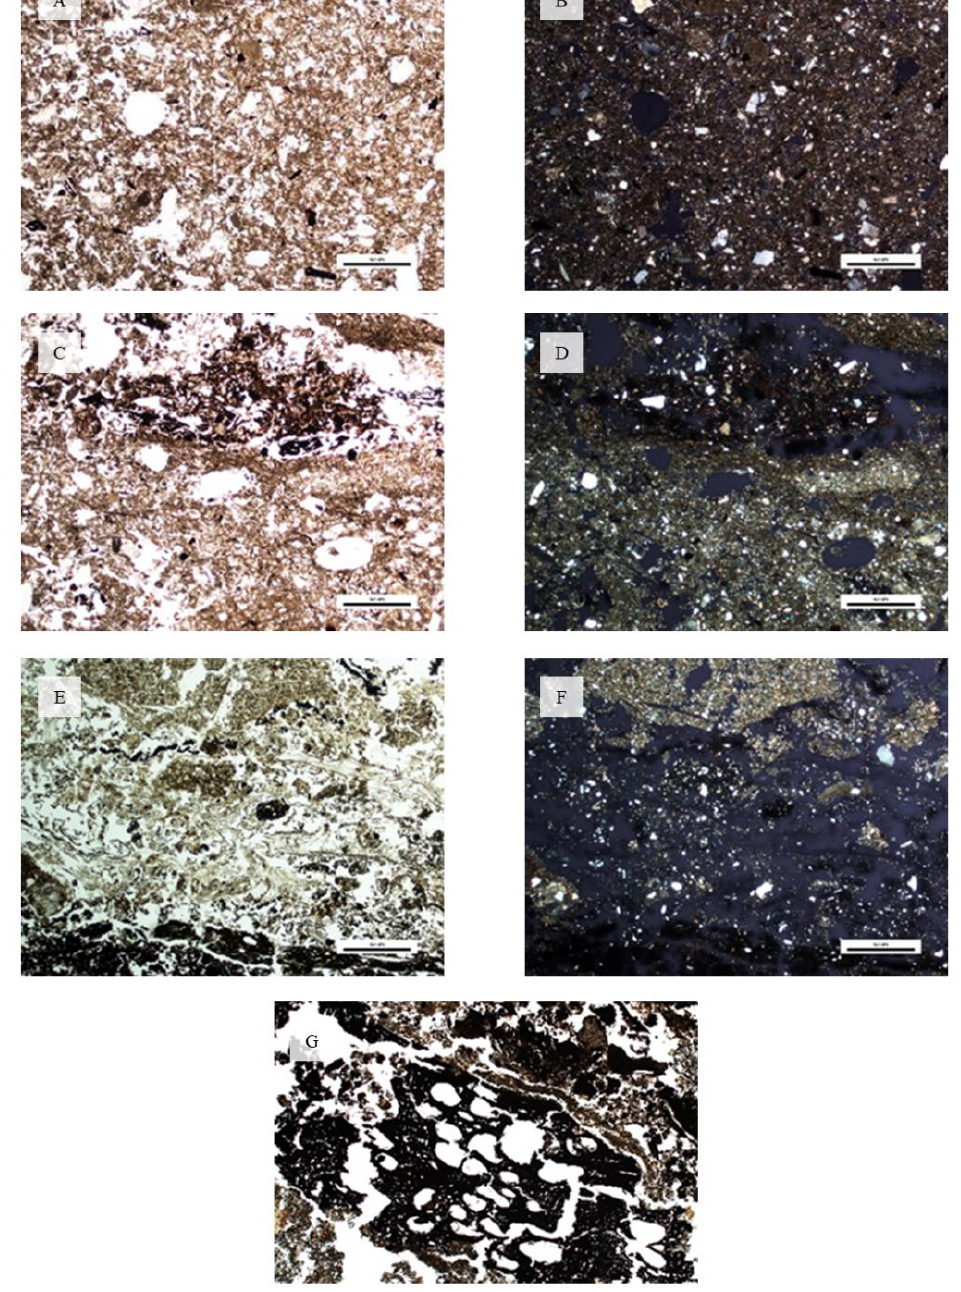
Figure 8. Microphotographs of MS43/1 2004: ( A , B ) material of the earthen floor (scale: 0.1 cm; PPL, XPL). ( C , D ) Fine, charred, laminated plant matter on the earthen floor (scale: 0.1 cm; PPL, XPL). ( E , F ) Material of the ashy layer on top of the charred horizon (scale: 0.1 cm; PPL, XPL). ( G ) cf. Quercus sp. charcoal (PPL, 50 ×